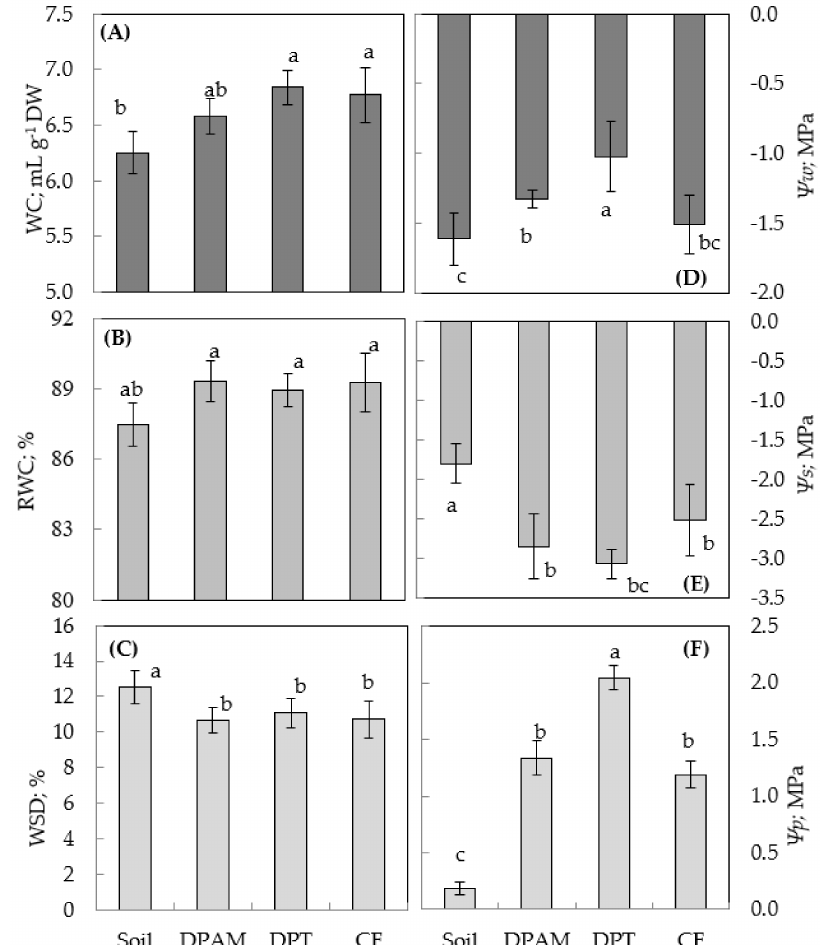
Figure 1. Variation of water parameters in leaves of melon plants cultivated on a different substrate. DPAM: compost of date palm residues and animal manure; DPT: compost of datepalm trunk; CF: coconut fiber, compared with soil substrate. ( A ): water content ( WC : mL g − 1 DW); ( B ): Relative water content ( RWC : %); ( C ): Water saturation deficit ( WSD : %); ( D ): Water potential ( Ψ w ; MPa